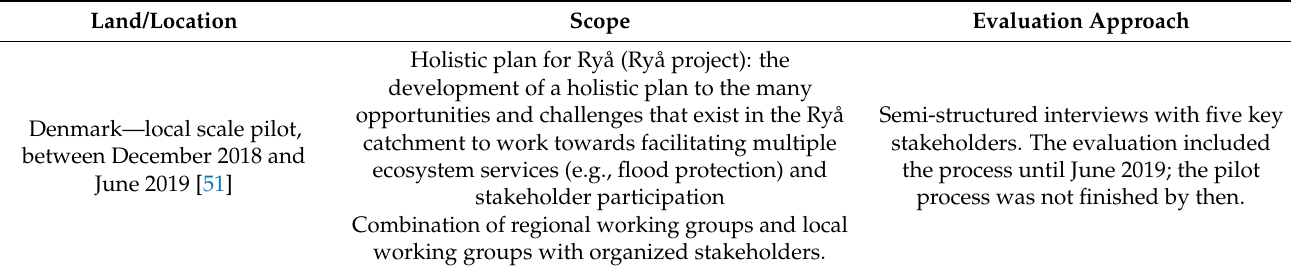
Table 1. Scope and method of evaluation for international